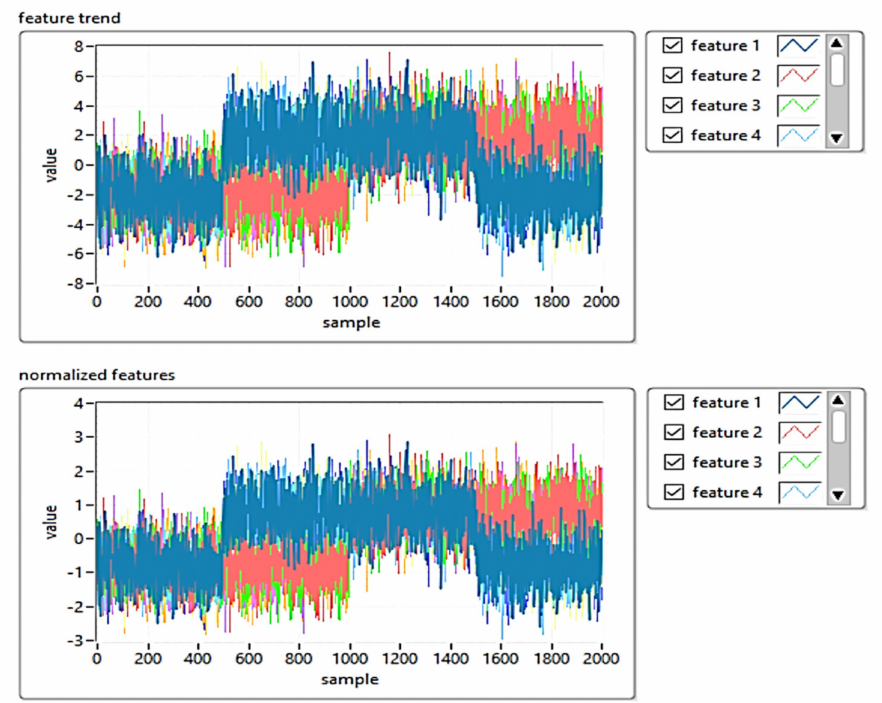
Figure 12. The results obtained for reducing the database size using the KPCA algorithm.